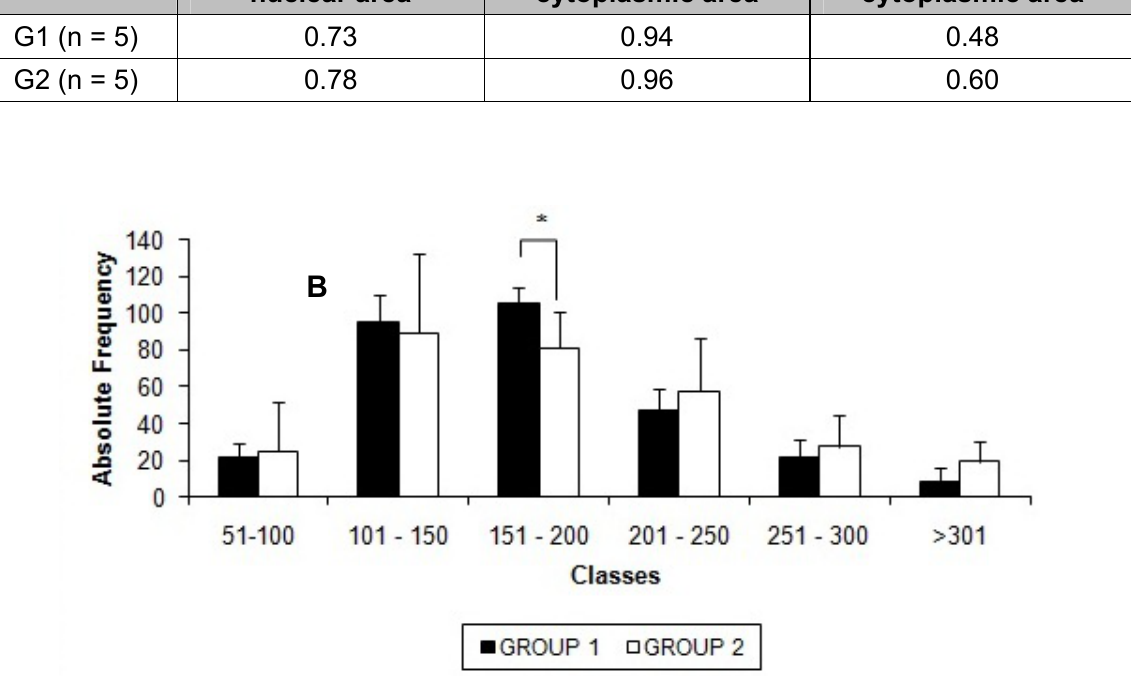
Figure 2. Histogram of the body area of jejunum myenteric neurons from healthy rats (G1) and those infected with a genotype III Toxoplasma gondii strain (G2). Marked columns from the same class differ significantly (p <